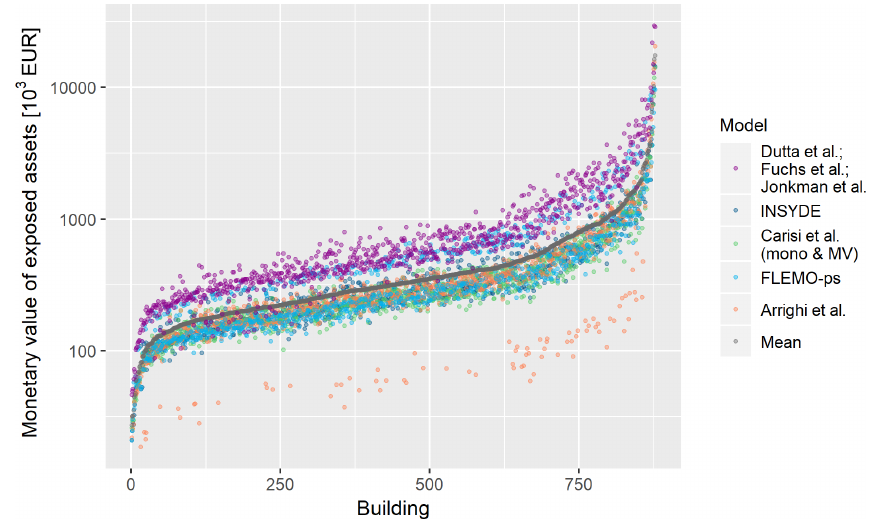
Figure 2. Individual estimates of the monetary value of the exposed assets for all the buildings in the flooded area. Data are ordered according to increasing value of mean estimate (in grey).